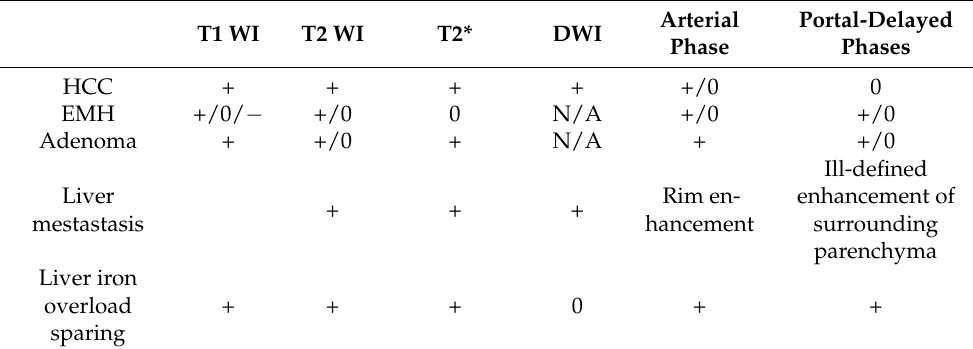
Table 3. Focal liver lesions’ appearance in diversely weighted sequences compared to the intensity of the surrounding iron overloaded liver parenchyma. T1